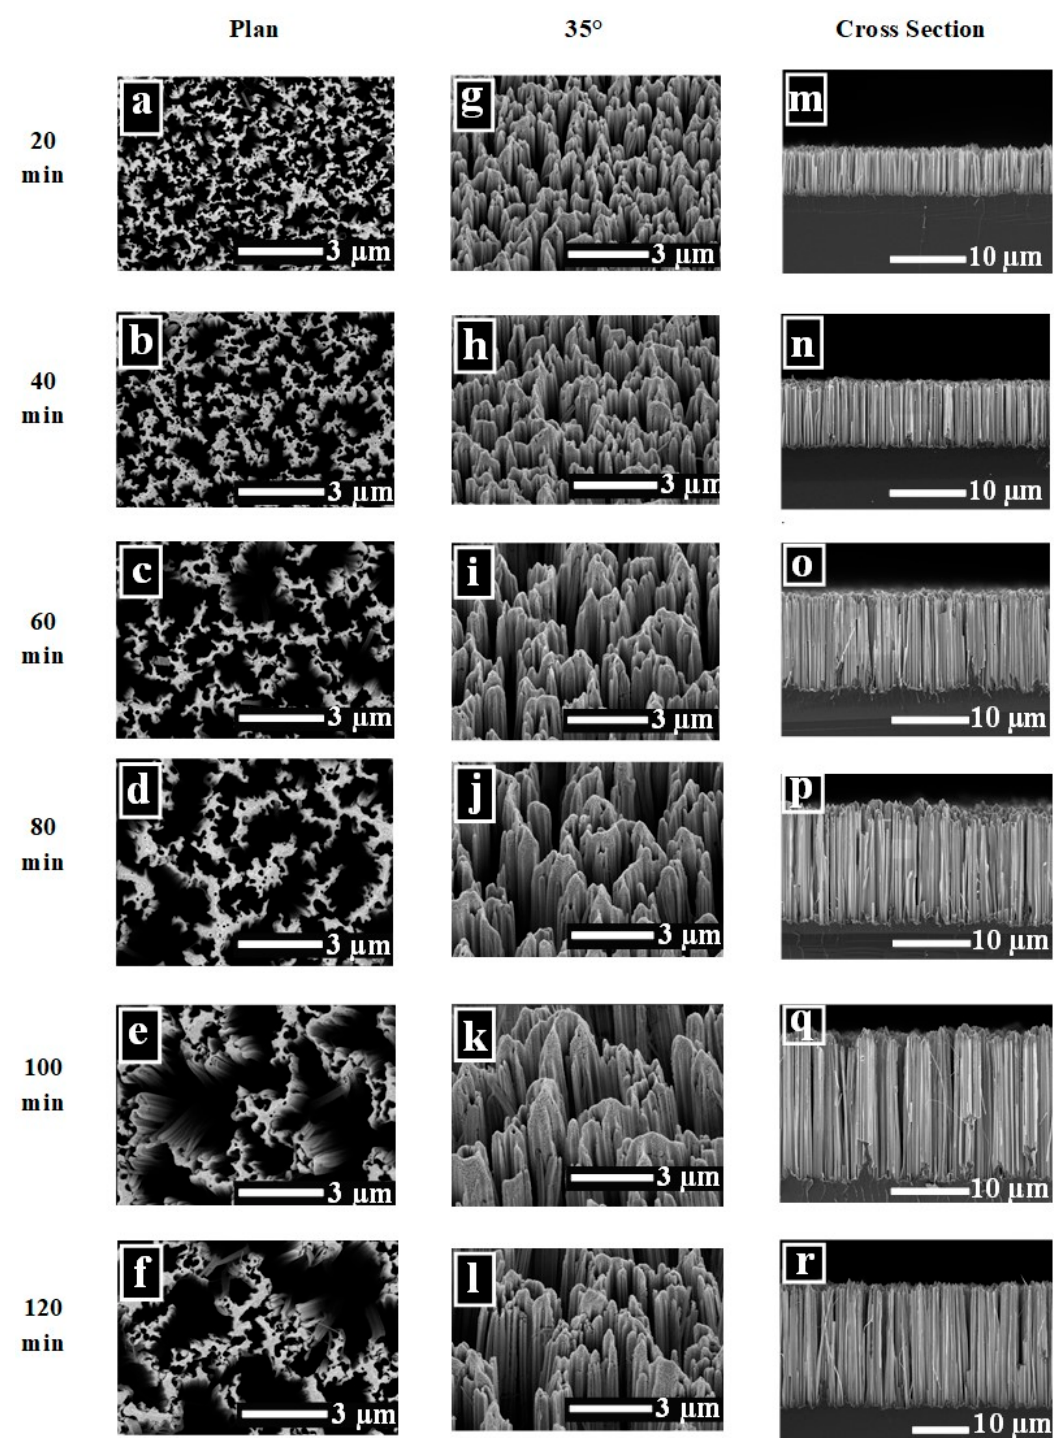
Figure 3. SEM images of SiNWs etched at different durations showing top view surface ( a – f ), tilt view 35° ( g – l ), and cross-sectional ( m – r ).